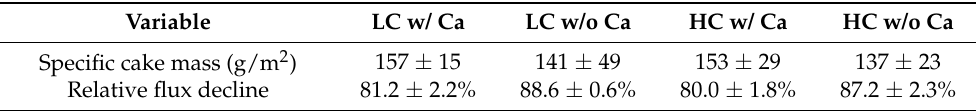
Table 2. Specific mass of recovered fouling layer after filtration and relative flux decline during 1000 s filtration of LC and HC suspensions with and without calcium ions.